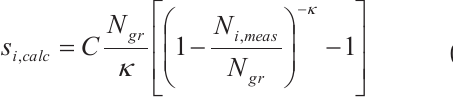
Figure 4: The results of static load tests of two model piles.